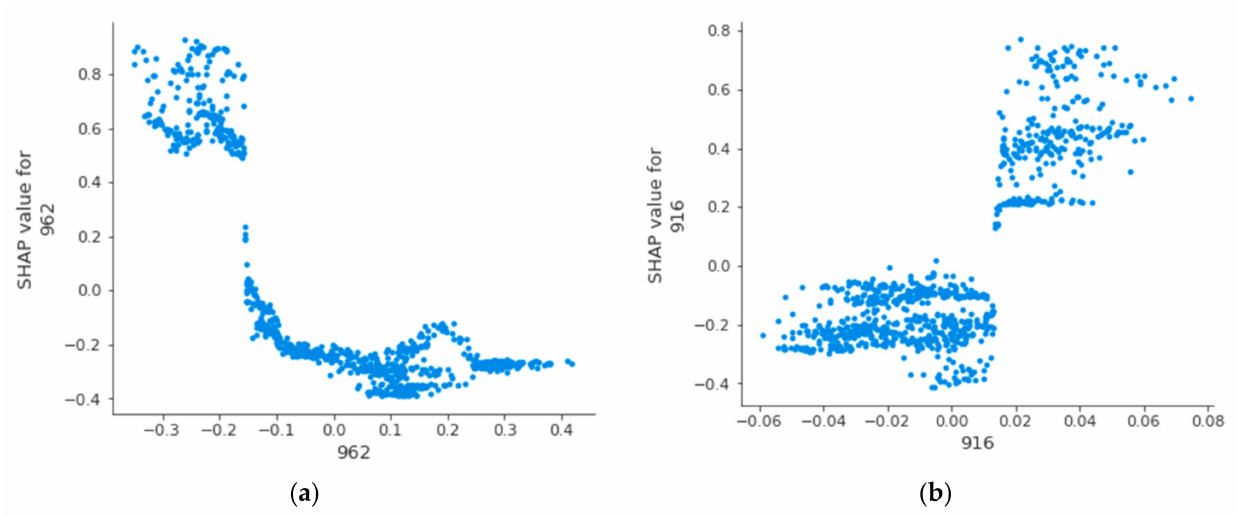
Figure 12. Shapley additive explanations (SHAP) value transition over feature value of random forest regressor to estimate DM content. ( a ) SHAP value for the feature of 962 nm; ( b ) SHAP value for the feature of 916 nm. X-axis represents feature value while Y-axis represents SHAP